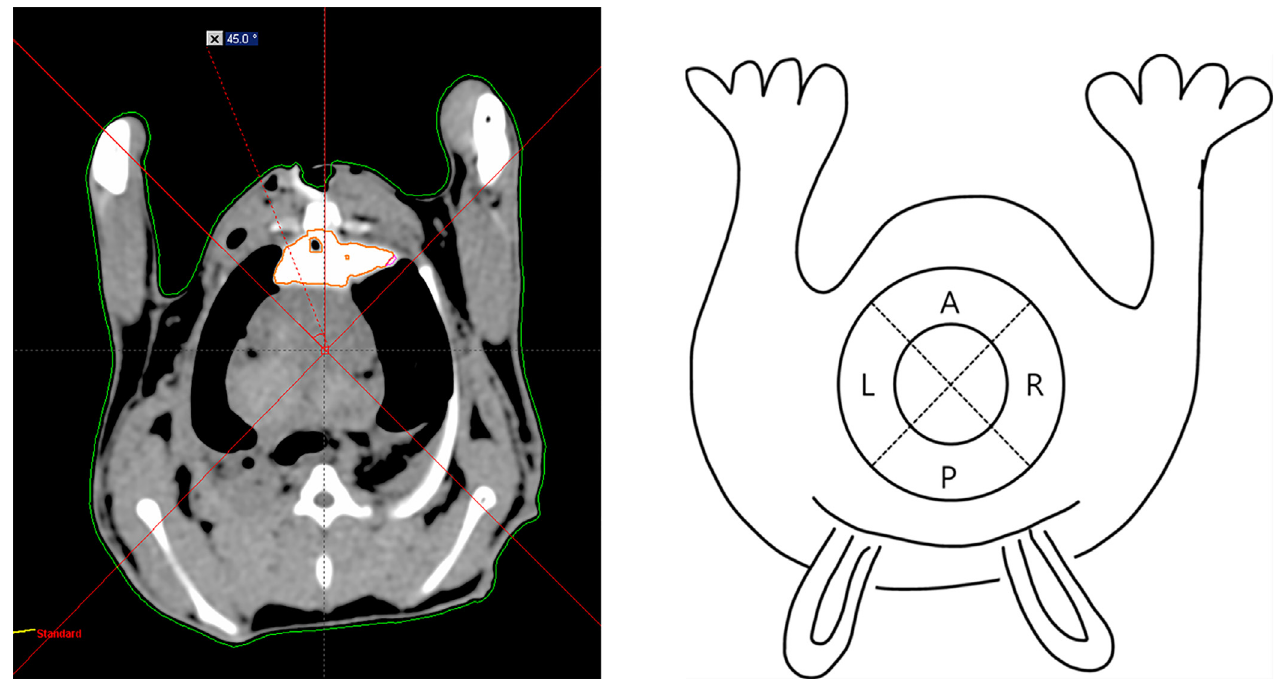
Fig 2. Example of image design for CT evaluation (left panel), and a schematic of a CT scan of four pericardial segments (right panel). A, anterior; P, posterior; L, left; R, right.